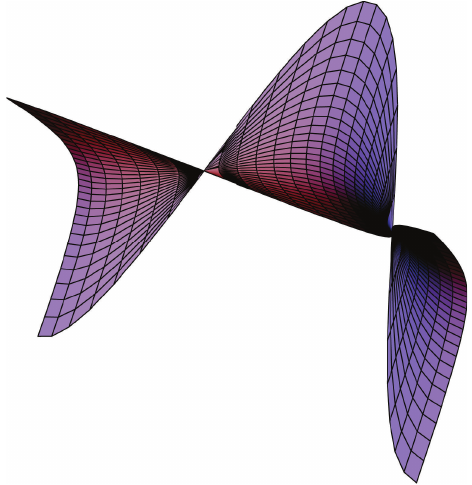
Figure 3: A spacelike (cid:3) timelike (cid:4) surface of revolution with negative (cid:3) positive (cid:4) curvature.